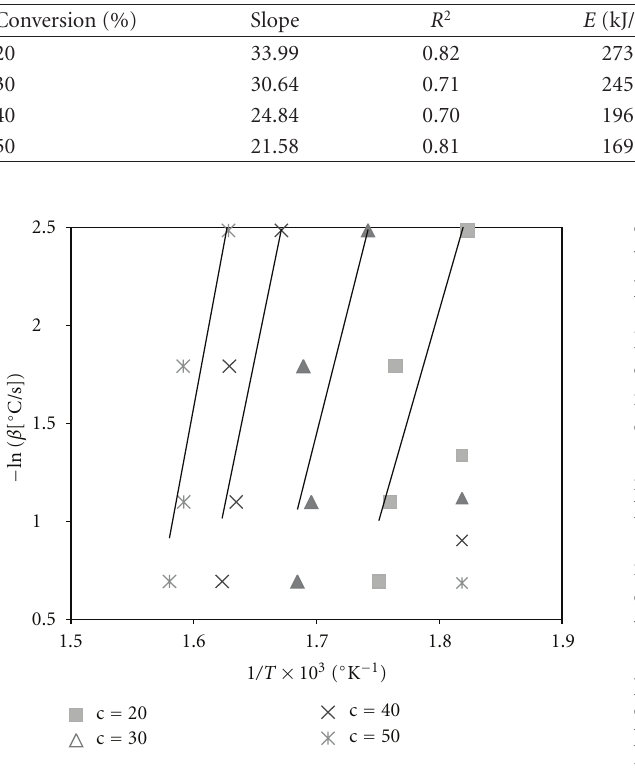
Figure 9: Curves to determine the activation energy of CH, based on the kinetic model proposed by [13], for various conversion degrees, adapted from